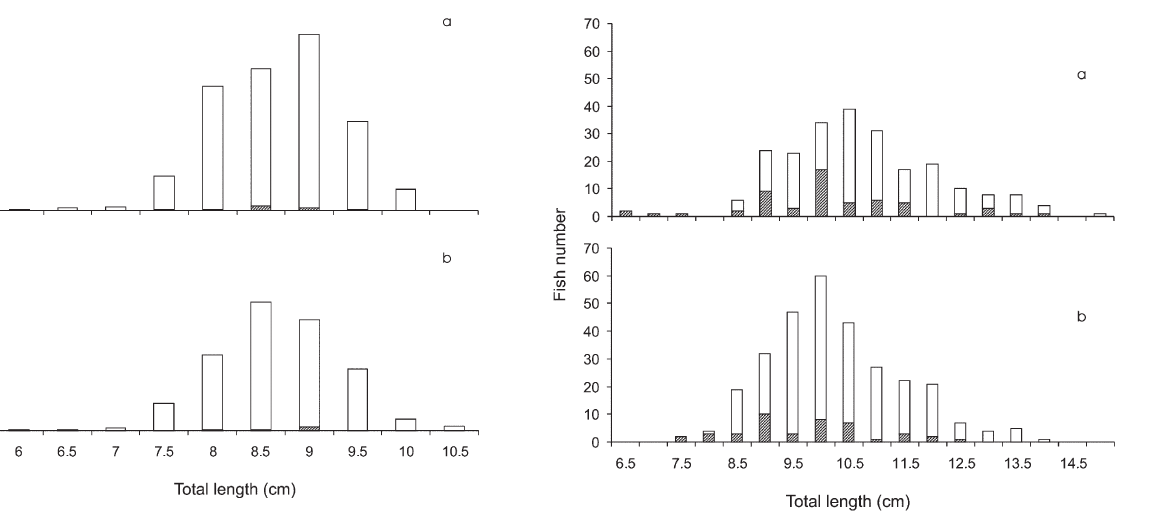
T able 1. – Total number ( n ) of brown comber, black goby and an- nular seabream, shown along with the number of mortalities ( n